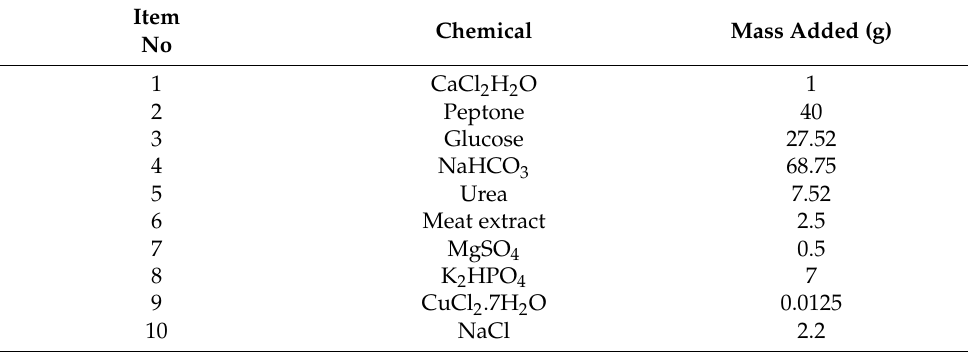
Table 1. Chemical composition of synthetic wastewater